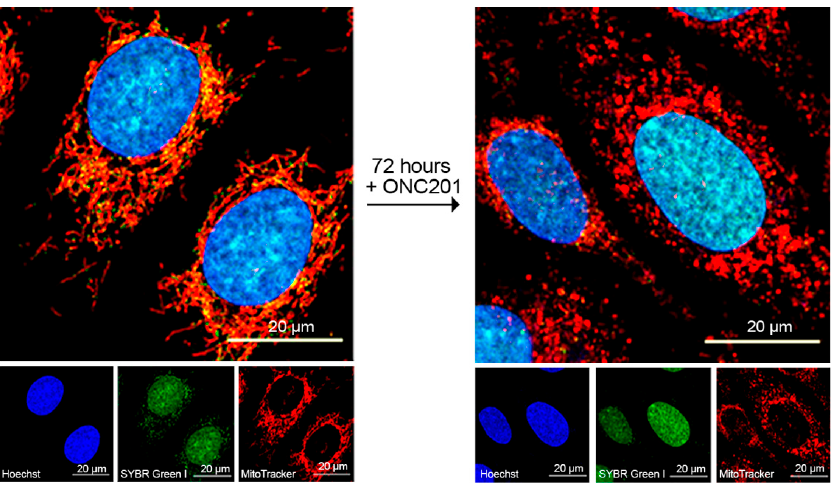
Figure 1. Effect of ONC201 on growth, viability, activation of Caspase-3/7, and morphology of BT474 cells. ( A ), Time- and dose-dependent inhibition of cell proliferation by ONC201. ( B ), Dose-dependent suppression of cell growth by ONC201 (96 h exposure). ( C ), Caspase-3/7 activation in untreated cells (None), cells treated for 72 h with 10 µ M ONC201 (ONC201) or 6 h with 0.5 µ M staurosporine (STS). Shown are mean +/ − SD from at least three independent experiments. Initial plating density of cells at time “zero” was 30,000 cells/cm 2 , * p < 0.05, “ns”, non-significant. ( D ), Confocal images of cells demonstrating viability of cells treated with 10 µ M of ONC201 for 72 h. Cells were loaded with 2 µ g/mL Hoechst 33342 (Blue, cell nuclei), 1 µ M Calcein-AM (Green, cytoplasm), and 150 nM Mito Tracker Deep Red (Red, mitochondrial mass) in HBSS buffer for 30 min at 37 °C.